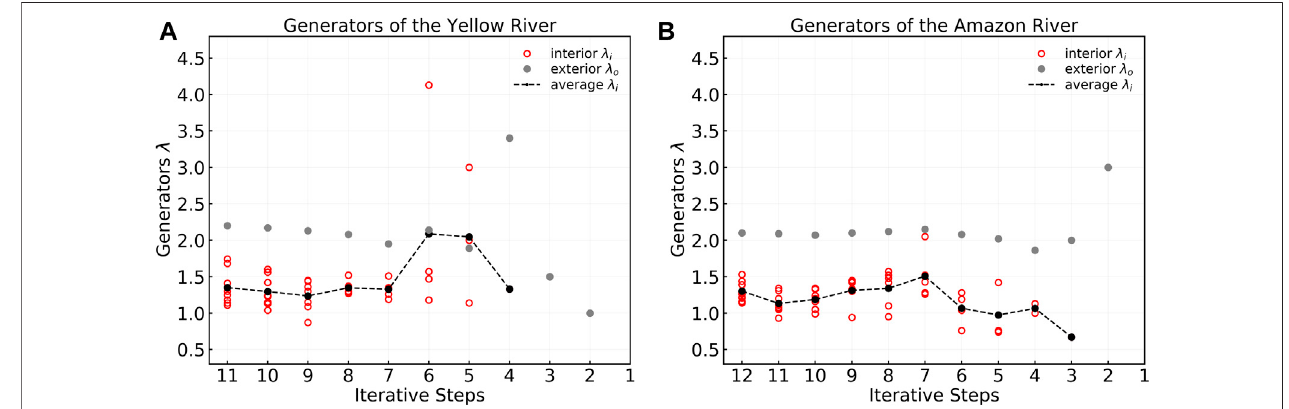
FIGURE12 | Generators ofthe Yellow River and theAmazonRiver for each iterative step. The gray solid points are the exterior generators λ o . Theblack circles are the interior generators λ i . The dotted black line corresponds to the average value of the interior generators λ i for each row, excluding those in the last column of Supplementary Table S4 . Analysis and Conclusions for Supplementary Table S4 and Figure 12 .